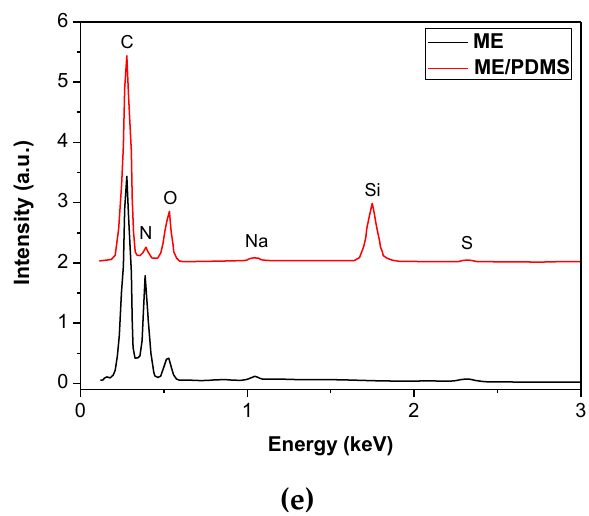
Figure 1. High-resolution Scanning Electron Microscopy (HRSEM) micrographs of the untreated Melamine (ME) ( a ) and ME/Polydimethylsiloxane (PDMS) cured at 80 °C ( b ). HRSEM image of a strut of the ME/PDMS foam ( c ) and the corresponding energy-dispersive spectroscopy (EDS) map ( d ) showing a homogeneous distribution of the Si corresponding to the PDMS (red). EDS spectra of ME and ME/PDMS foams ( e ).